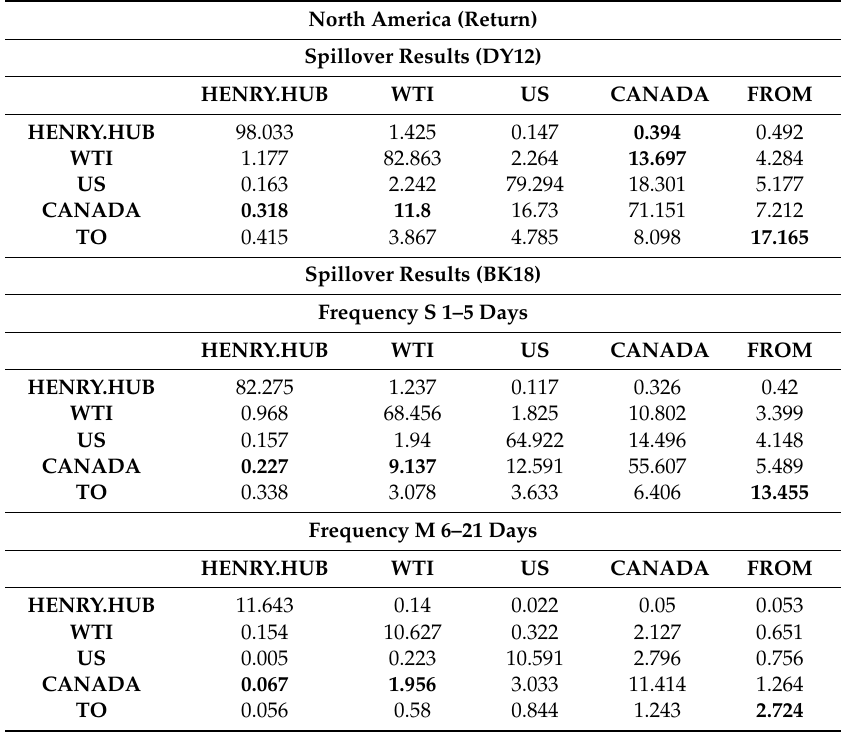
Table 4. The return spillover table of DY, 2012 and BK, 2016 (North